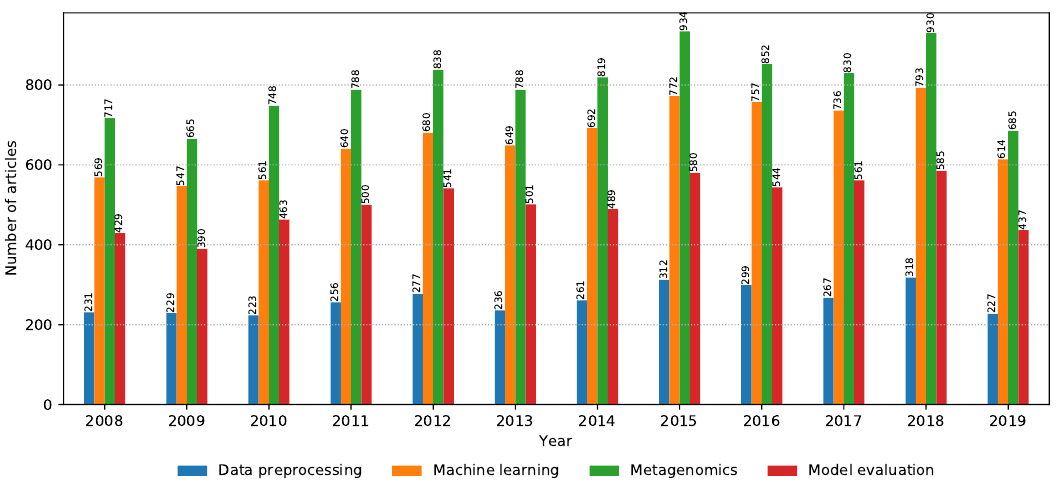
Figure 8. Annual distribution of the number of relevant articles for each property group.